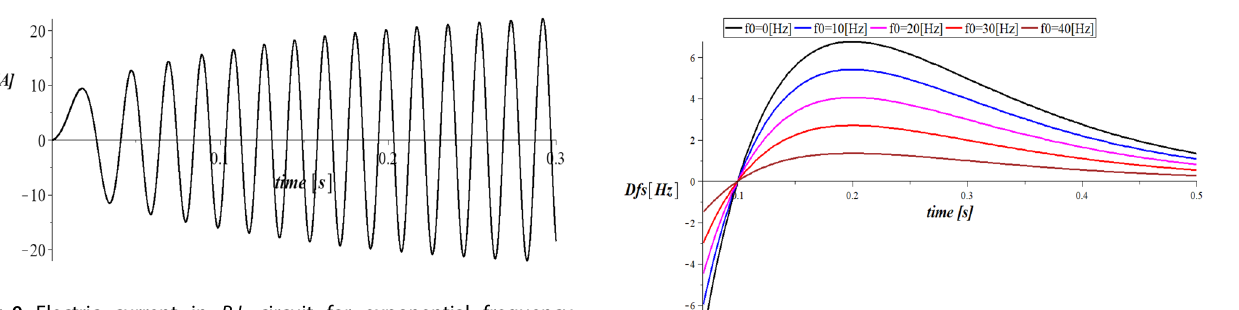
Fig. 9 Electric current in R,L circuit for exponential frequency increase of voltage; T = 0.075 s